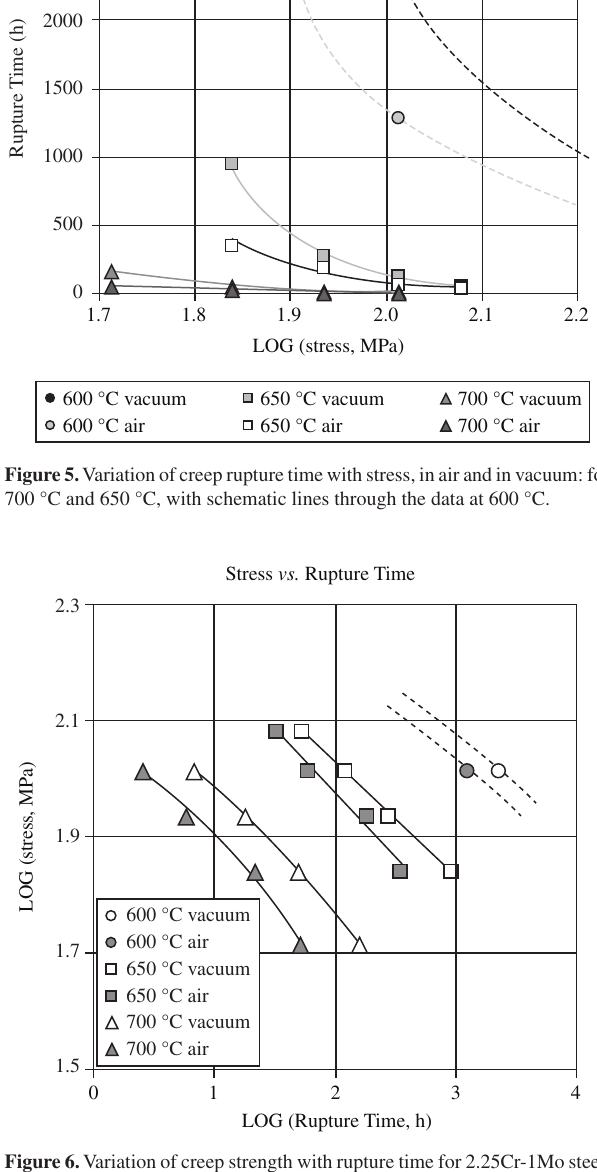
Figure 8. Variation of minimum creep rate with rupture time for 2.25Cr-1Mo steel, in air and